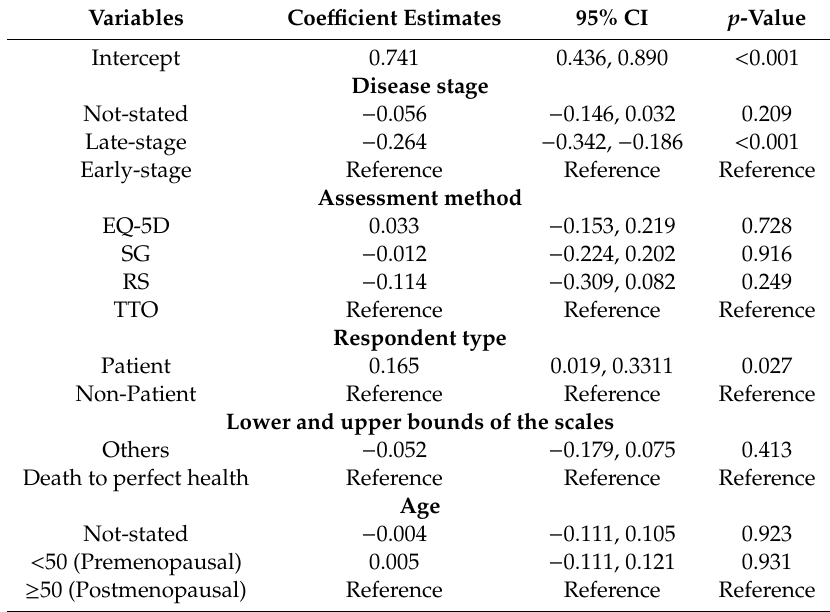
Table 4. The result of the HLM model ( n = 75, only including Asian countries): coe ffi cient estimates, p -values, and 95% confidence intervals (CI) for the predictors of